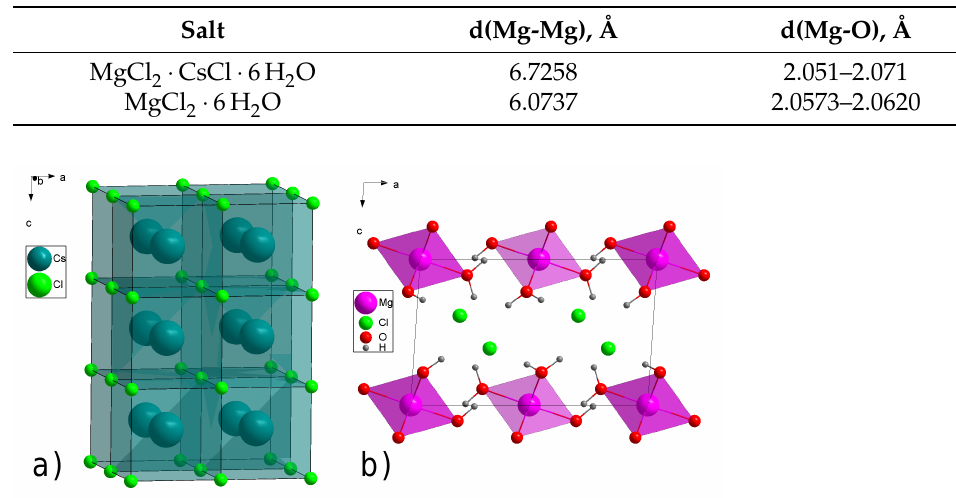
Figure 3. The structures of simple constituents salts. ( a ) the structure of anhydrous CsCl salt; ( b ) the · 6H structure of MgCl O 2 2